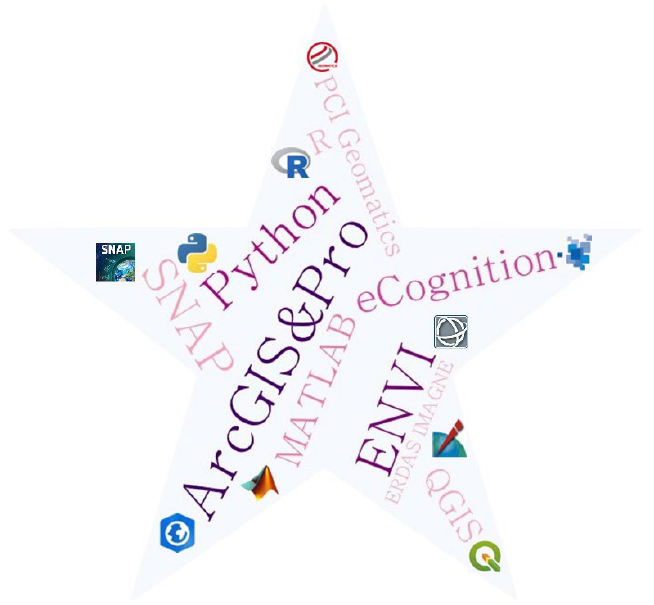
Figure 20. The main tools used for data preprocessing and processing in wetland studies. The larger the text, the more frequently the tool used in papers.